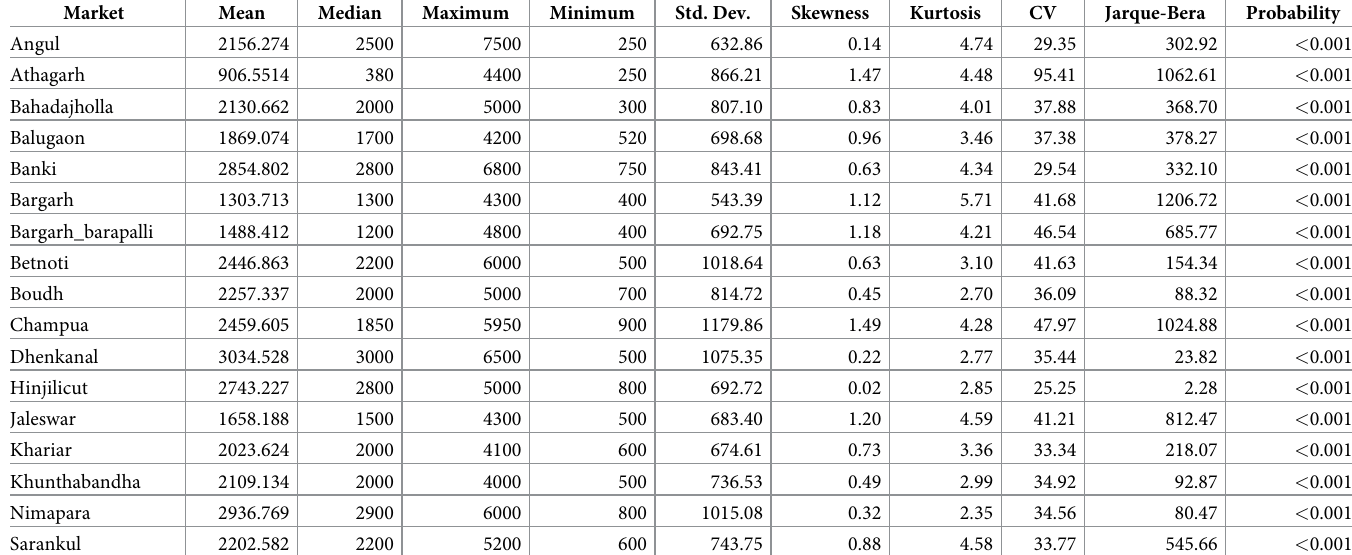
Table 1. Summary statistics.